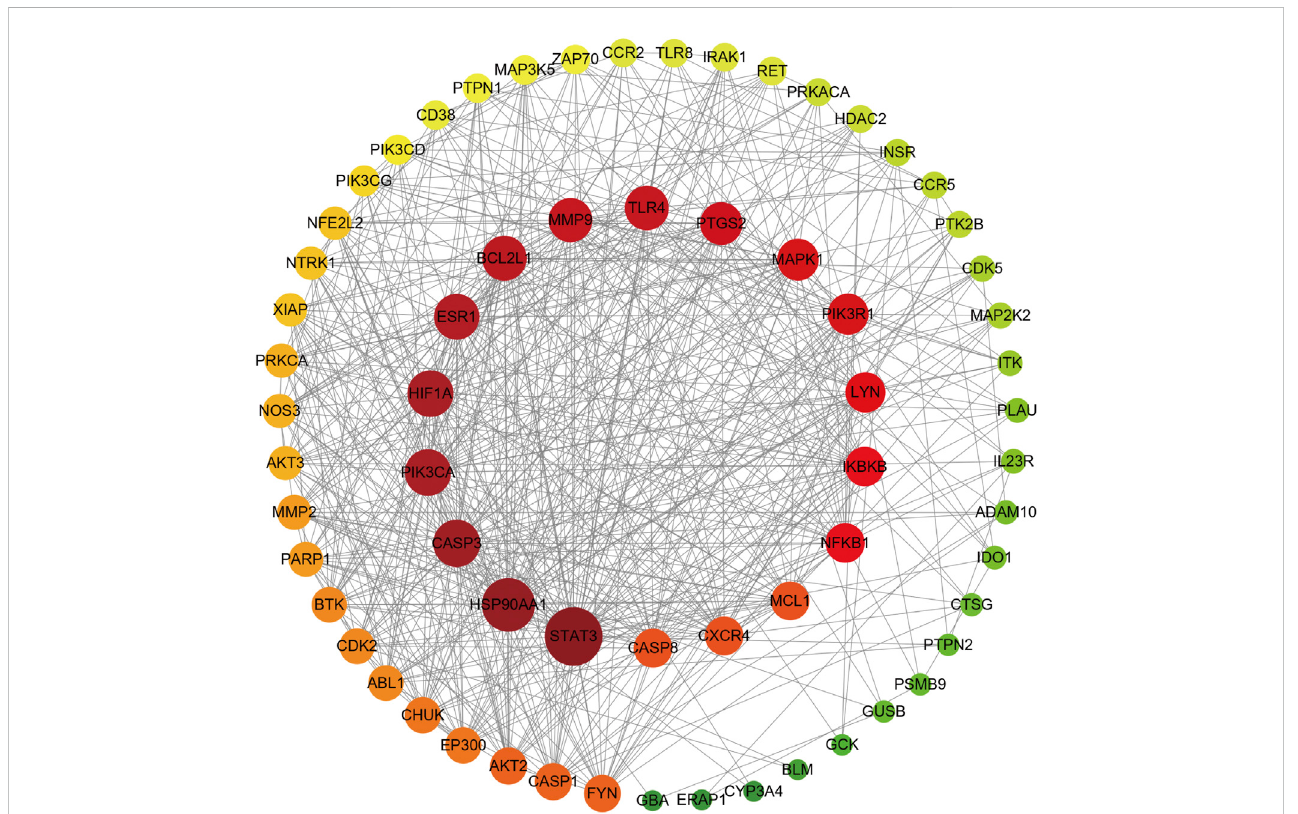
FIGURE 5 PPI network. The color and size of the nodes represent the size of the degree value, with darker red and larger nodes representing larger degree values; the inner circle represents degree values above the median.